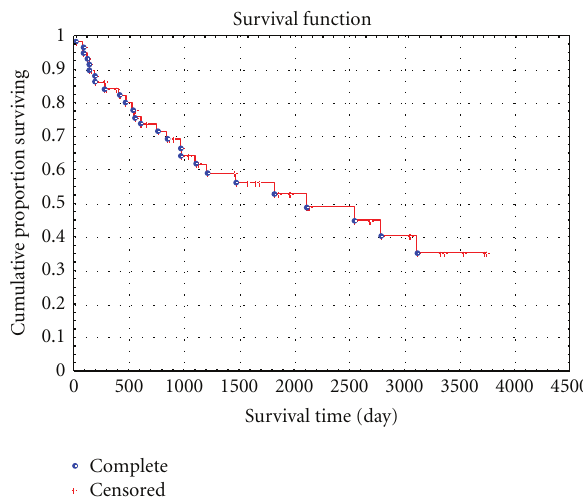
Figure 6: Cumulative proportion of 10-year survival of LMS pa-